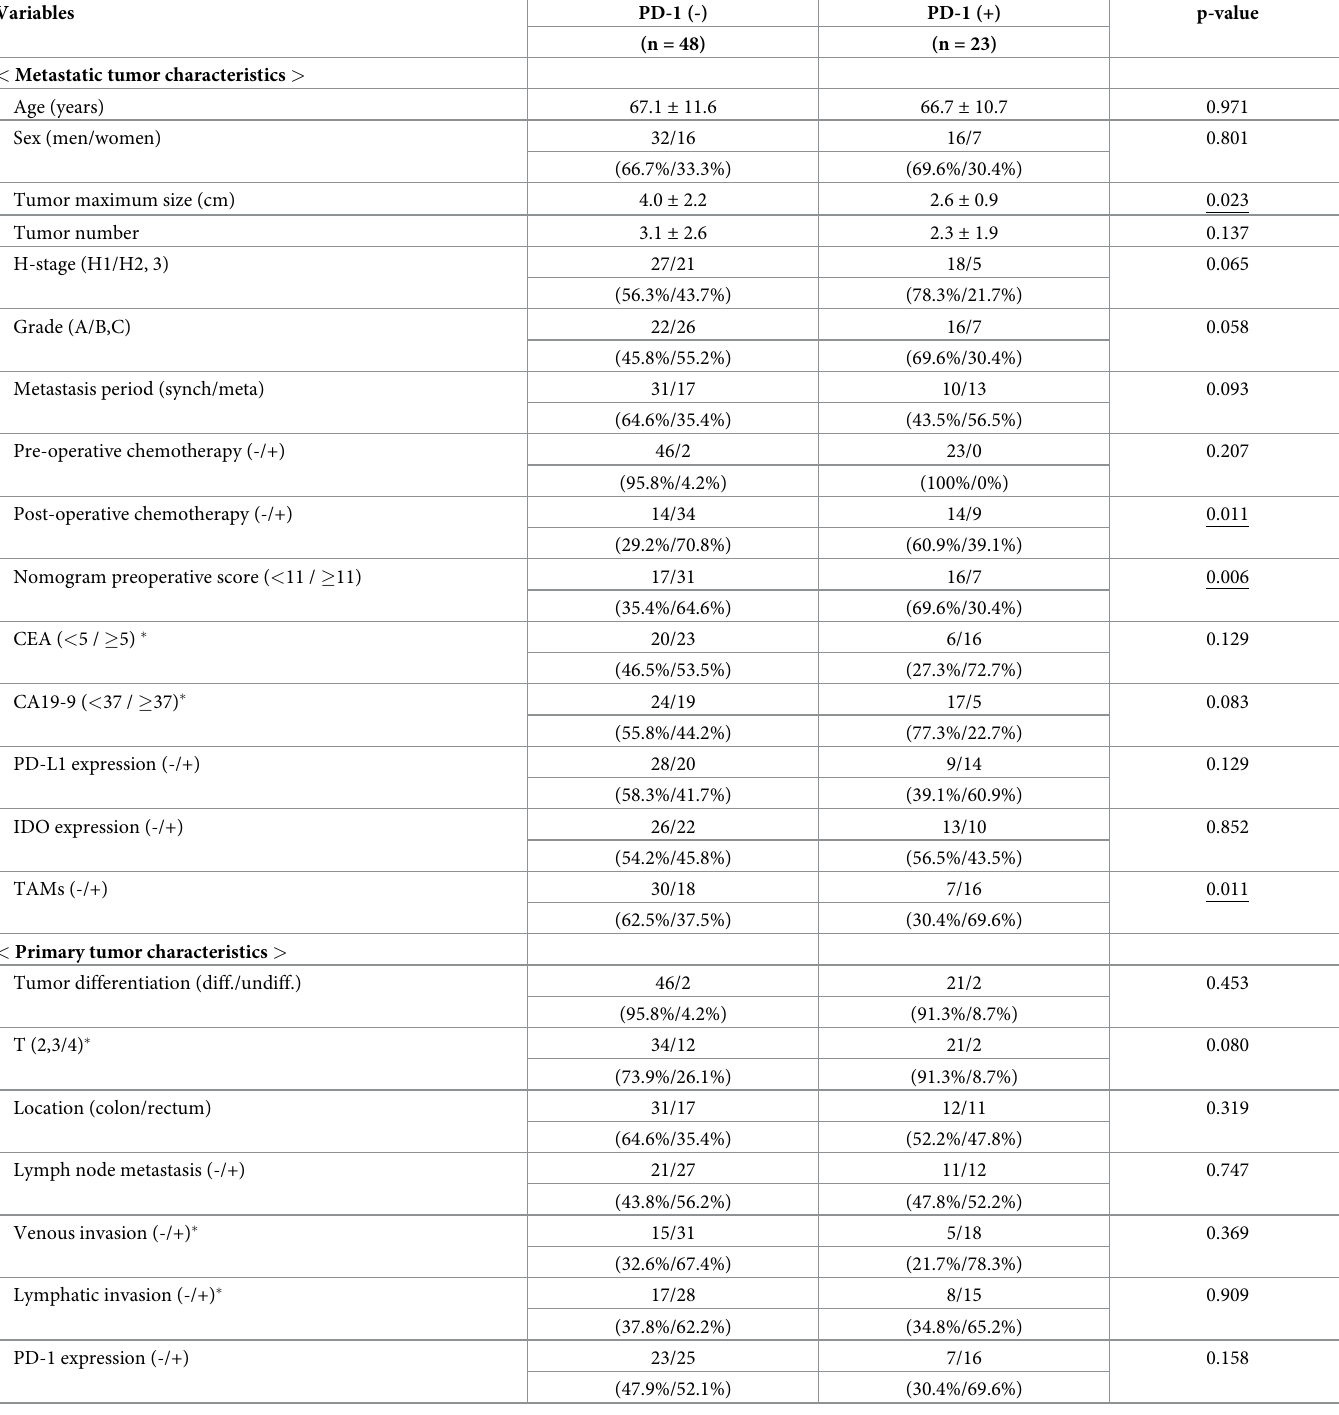
Table 1. Patients’ clinicopathological characteristics according to PD-1